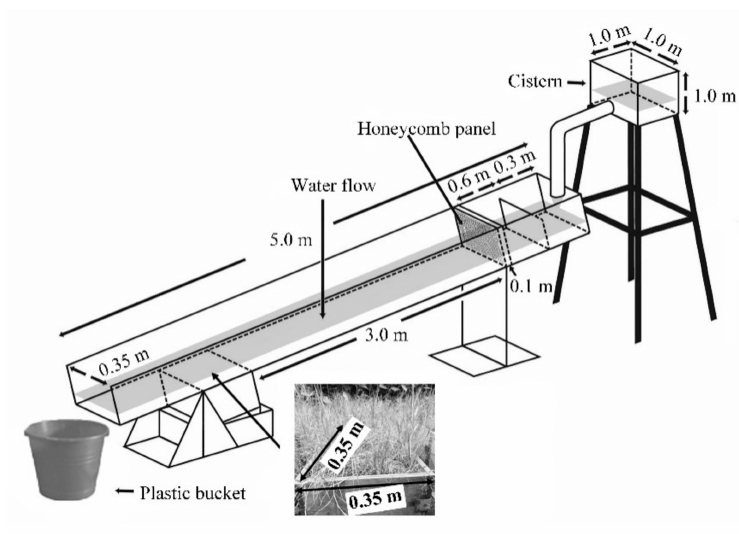
Figure 2. Graphic illustration of hydraulic flume